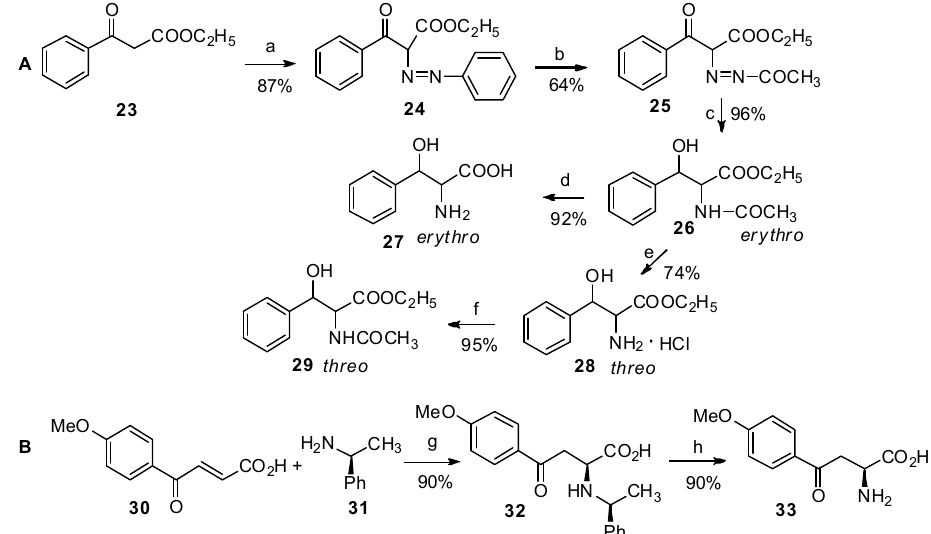
Scheme 5. Preparation of aryl-keto α -amino acids from non-amino acid